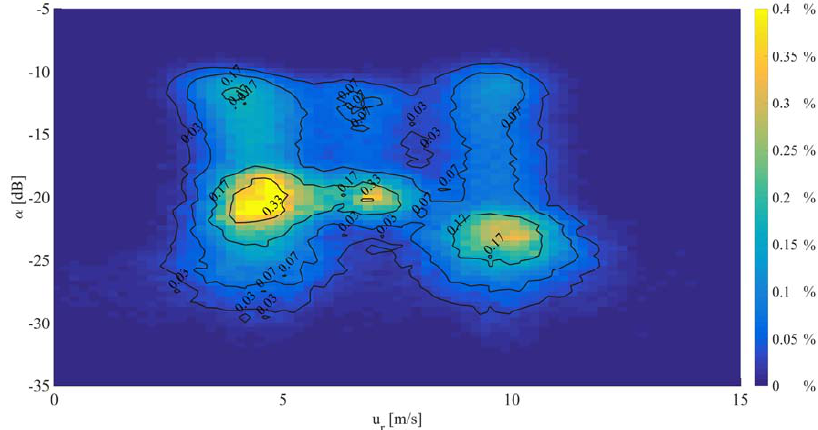
Remote Sens. 2017 , 9 , 561 7 of 30 Figure 3. Example of data-density distribution of a 30-min time interval of LiDAR staring mode Figure 3. Example of data-density distribution of a 30-min time interval of LiDAR staring mode measurements in the original (cid:1873) (cid:3045) –(cid:2009) frames of reference. Iso-lines show levels of probability of Applying the normalisation means switching the reference frame from (cid:1873) (cid:3045) –(cid:2009) to (cid:1873) (cid:3045)(cid:4593) –(cid:2009) (cid:4593) . This occurrence of the measurement with in a bin of 0.32 m/s width and 0.2 dB height. measurements in the original u r - α frames of reference. Iso-lines show levels of probability of occurrence compensates spatial and temporal inhomogeneities and results in a denser data distribution where of the measurement with in a bin of 0.32 m/s width and 0.2 dB height. outliers can be identified with less effort.